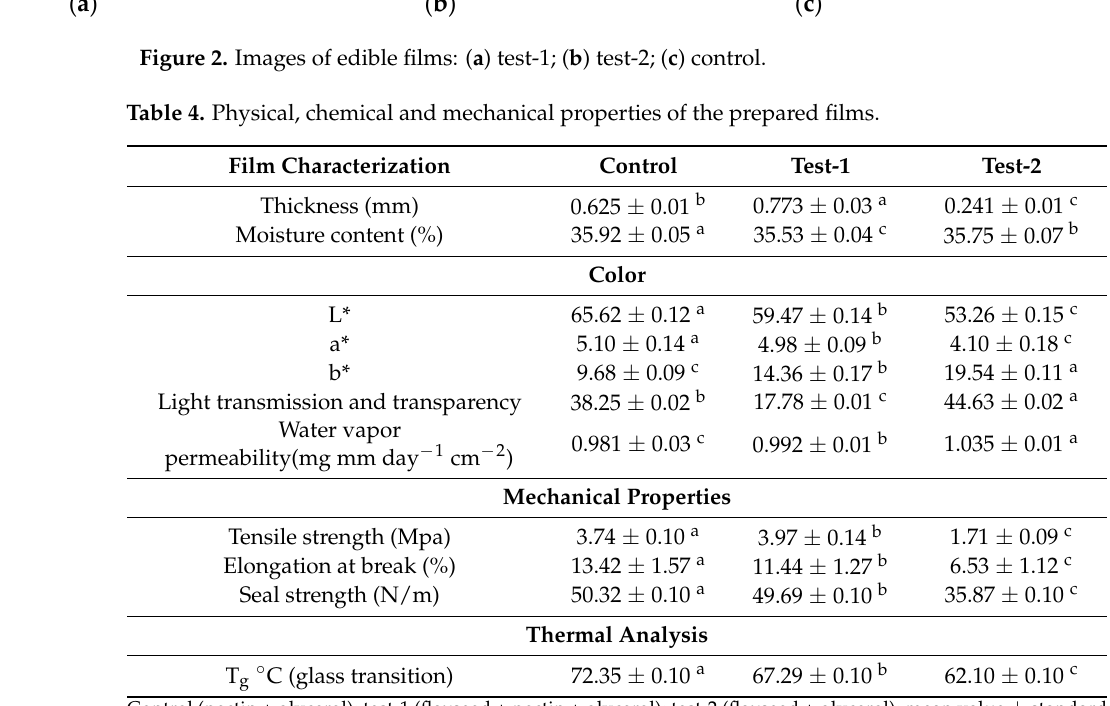
Table 4. Physical, chemical and mechanical properties of the prepared films.